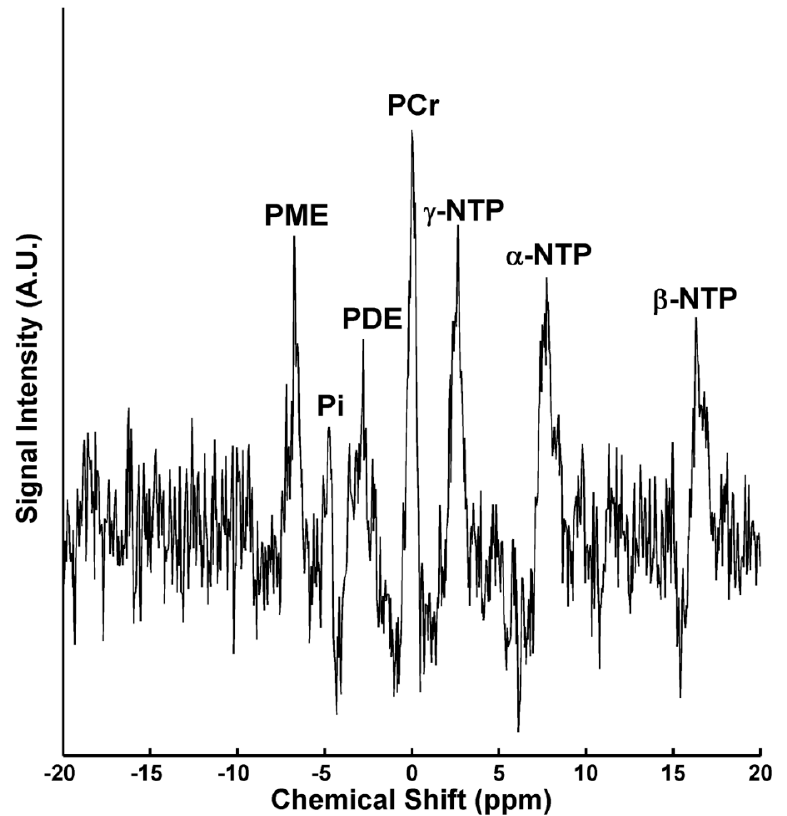
Figure 1. Example phosphorus 31 magnetic resonance spectrum from the frontal lobes of a single